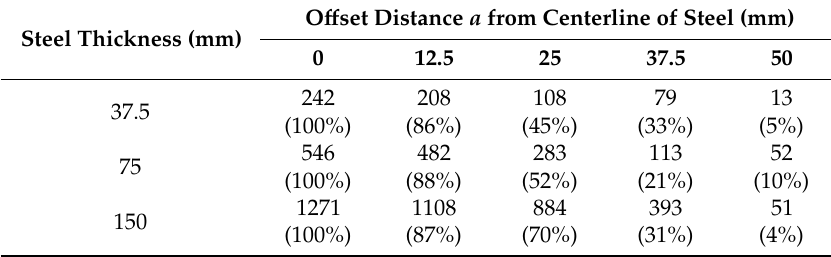
Table 2. ∆ V (m / s) for depth variation at t = 20 mm and h = 150 mm.